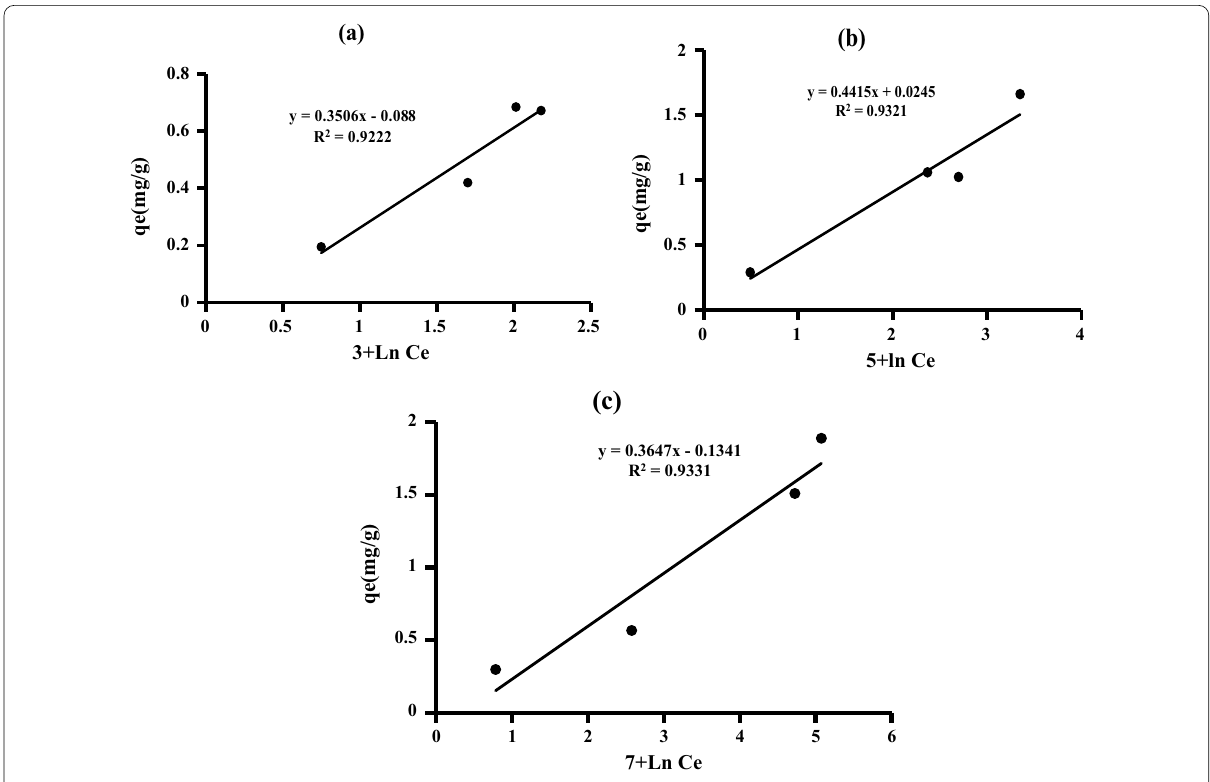
Fig. 12 Temkin isotherm of copolymer ( a ), aniline graft ( b ) and 2‑chloroaniline graft ( c )